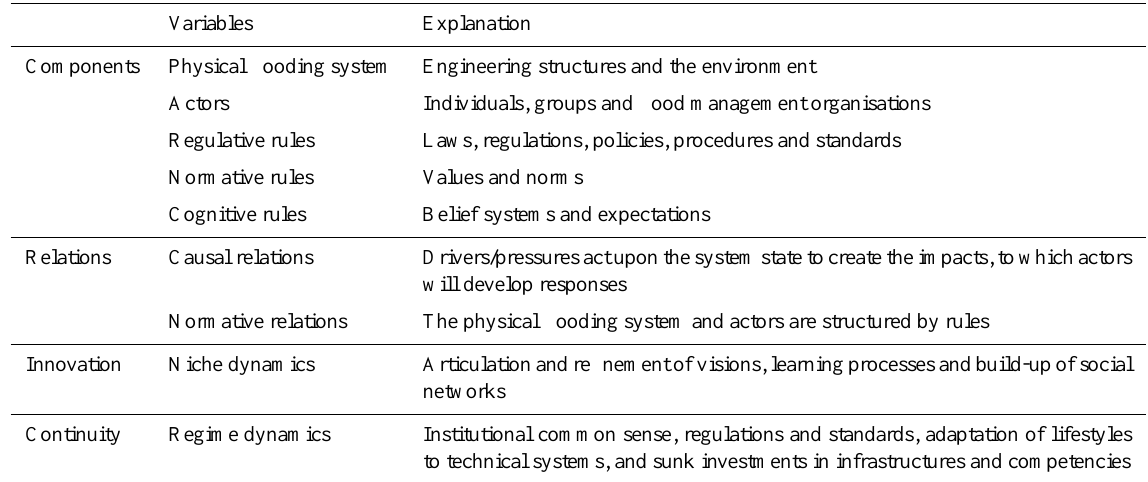
Table 1. Aspects of